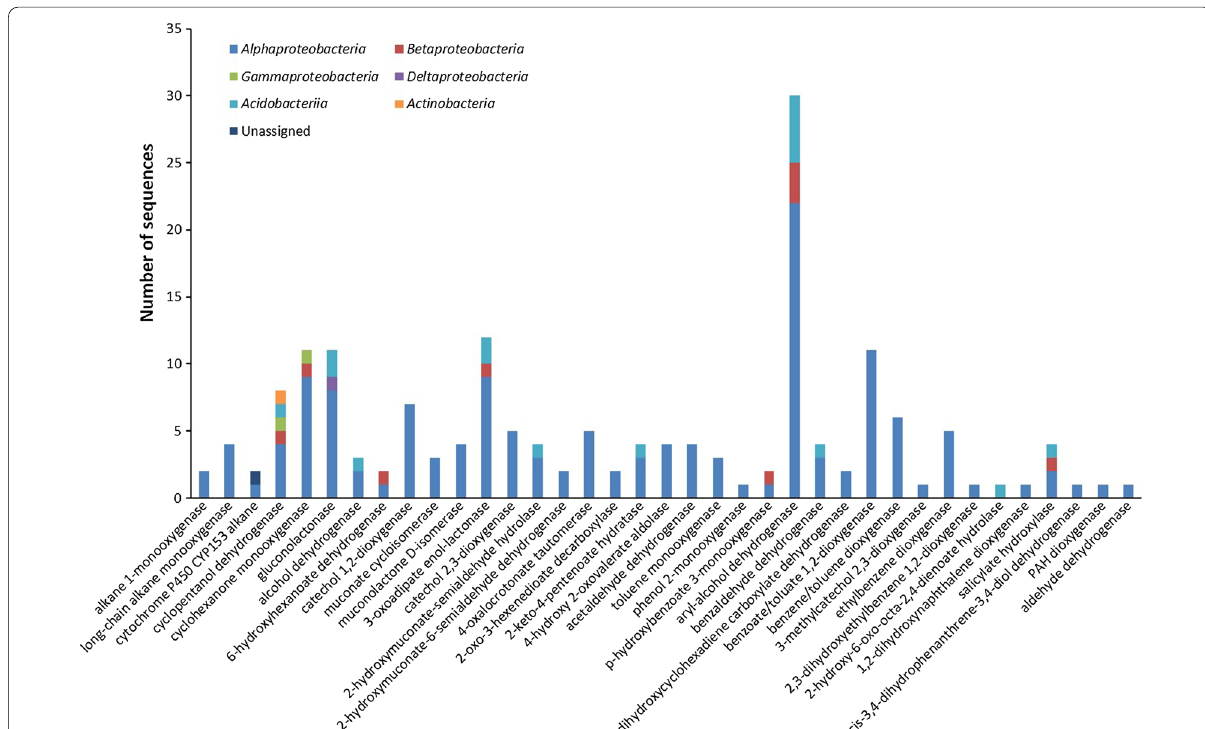
Fig. 4 The number of sequences associated with specific hydrocarbon-degrading enzymes in each taxonomic group. The analysis was based on the metagenome of the S3E3 enrichment